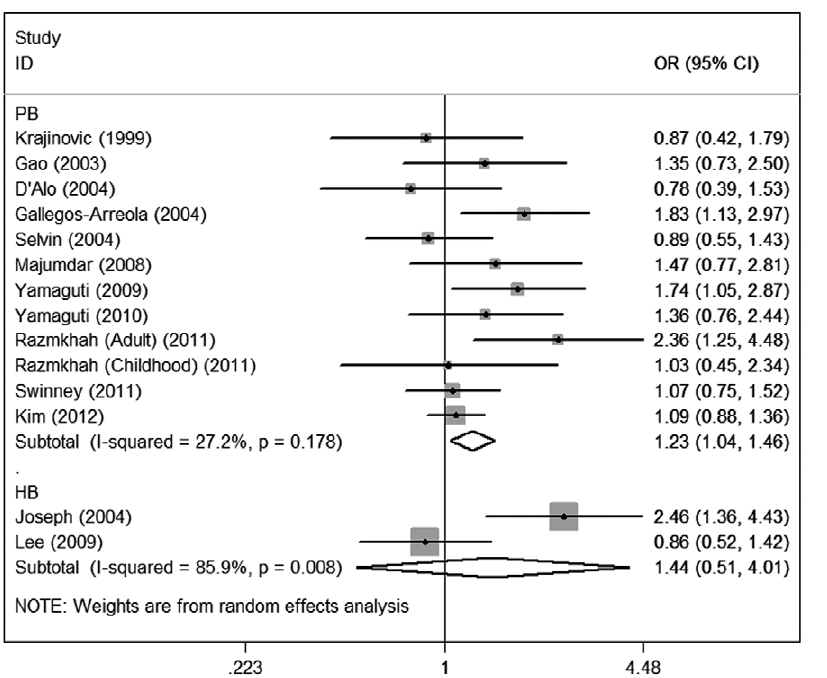
Figure 5. Meta-analysis for the association of acute leukemia risk with CYP1A1 Ile462Val polymorphism stratified by source of controls (Val/Val + Val/Ile versus Ile/Ile). PB: population-based; HB: hospital-based.